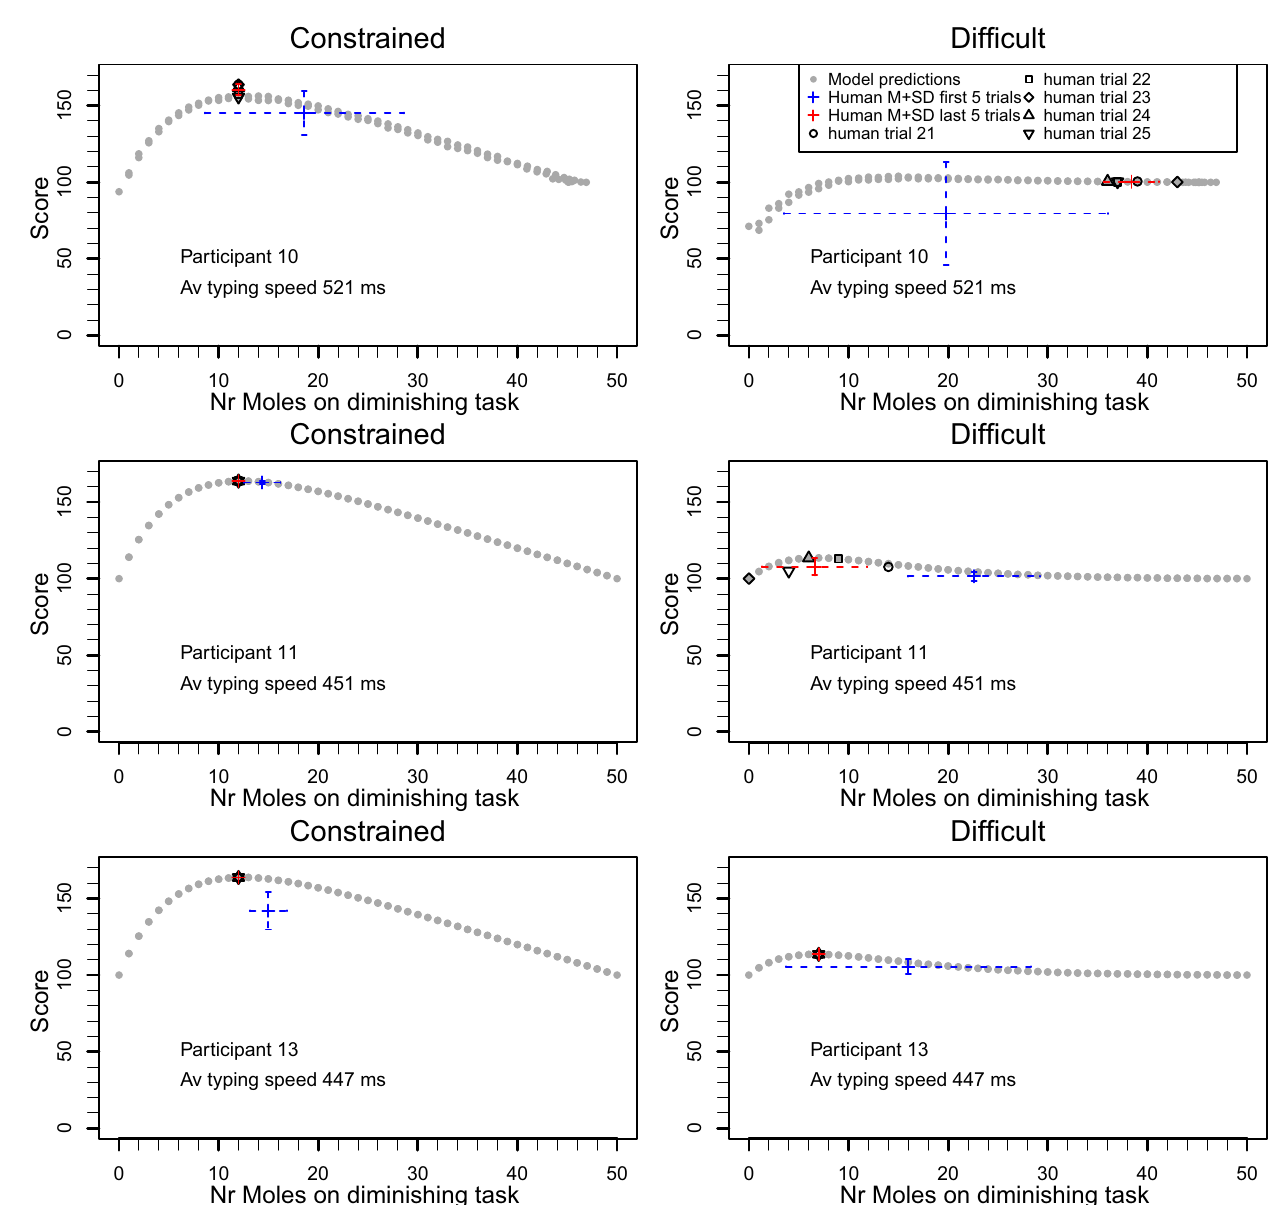
Fig 6. Illustration of the individual pay-off curves of 3 participants (rows) in two payoff conditions. The shape of the curve changes based on typing speed, especially in the difficult condition. Participants change their strategies with experience, and based on the nature of their individual pay-off curve.